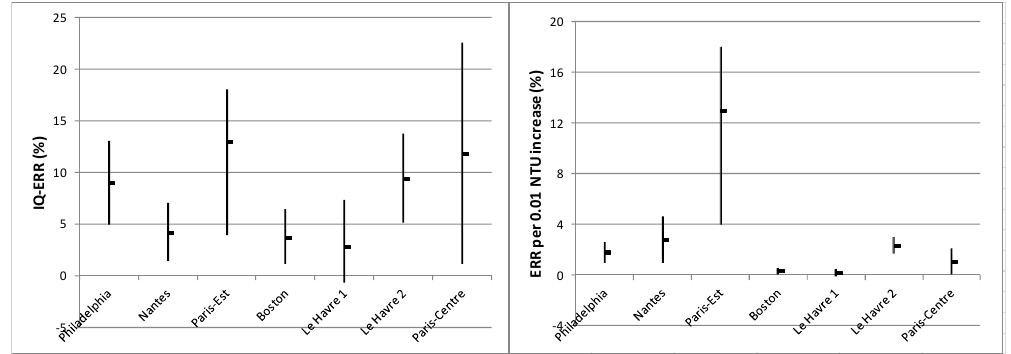
Figure 3. Excess of relative risk (ERR) associated to turbidity increase in finished water in six urban areas.